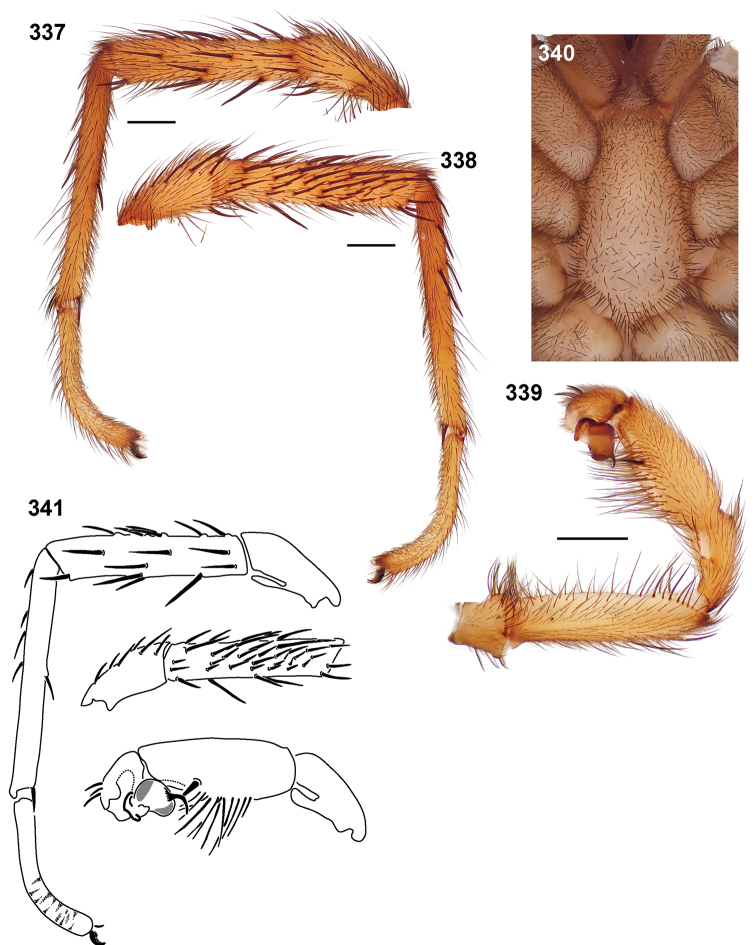
Aptostichus huntington sp. n. male holotype (AP408) from Fresno County; scale bars = 1.0mm. 337 retrolateral aspect, leg I [806469] 338 prolateral aspect, leg I [806473] 339 retrolateral aspect, pedipalp [806475] 340 sternum [806477] 341 line drawings of leg I and pedipalp spination patterns; retrolateral aspect patella, tibia, metatarsus, and tarsus; prolateral aspect tibia and patella; retrolateral aspect, pedipalp.